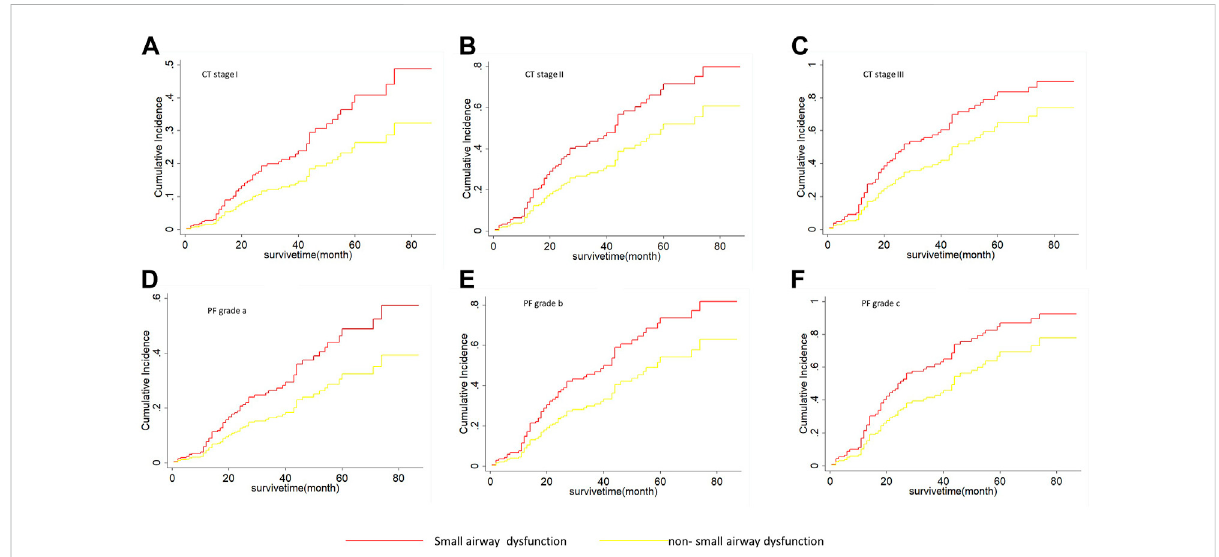
FIGURE 5 The cumulative risk of death with SAD and non-SAD in different CTPF stages based on the Fine-Gray regression model. (A) Cumulative death risk curve of patients with SAD and non-SAD in CT stage I; (B) Cumulative death risk curve of patients with SAD and non-SAD in CT stage II; (C) Cumulative death risk curve of patients with SAD and non-SAD in CT stage III; (D) Cumulative death risk curve of patients with SAD and non-SAD in grade a; (E) Cumulative death risk curve of patients with SAD and non-SAD in grade b; (F) Cumulative death risk curve of patients with SAD and non-SAD in grade c. As the cumulative dearth risk curve show, IPF comorbid SAD had a high dearth risk in all different CTPF stages. The red curve indicates that PFT diagnoses SAD. The yellow curve indicates that PFT diagnoses non-SAD. Note: CTPF model: A Mortality Risk Prediction model used to evaluatethe severity of IPF based on Arti fi cial Intelligence which was established by Li HP et al. CT stage: The stage was determined by using AIaccordingtothesysteminstalledbyLiHPetal.CTI:Honeycombarearatewas < 5%oftheentirelung.CTII:Honeycombarearatewas5% – 25%of the entire lung. CT III: Honeycomb area rate was > 25%. PF grade: The grade was determined by using the pulmonary function and physiological parameters (age, gender, FVC% pred, DLco% pred, and SpO 2 %). The grade was de fi ned as: mild (A) , moderate (B) , and severe (C) .